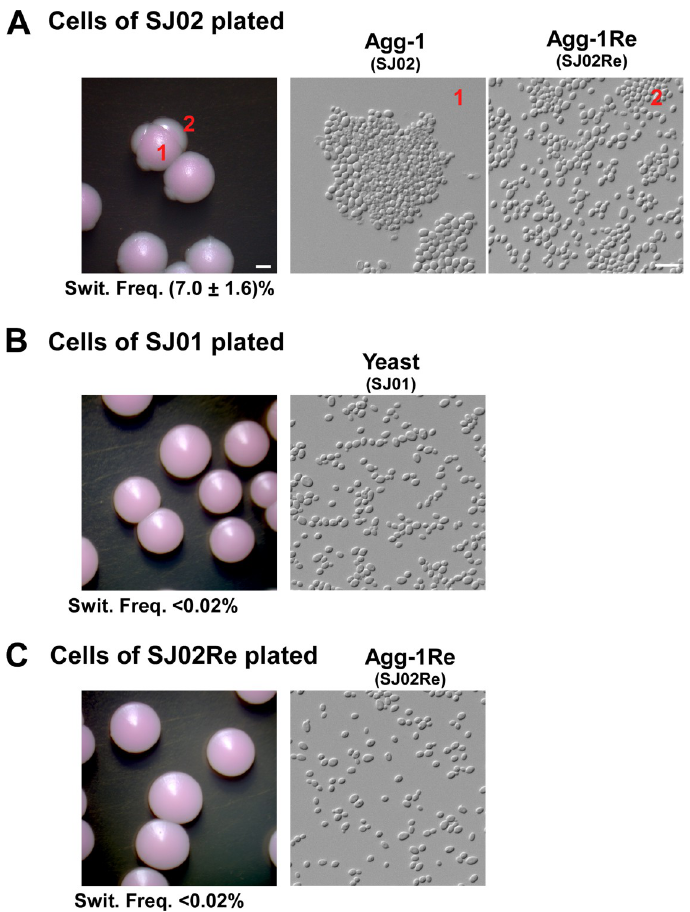
Fig 3. Spontaneous switching between the aggregating form and the single-celled nonaggregative/yeast-form. C . auris cells of the original aggregating form (Agg-1, SJ02), SJ01 nonaggregative/yeast-form, or SJ02Re nonaggregative/ yeast-form were plated onto solid YPD medium containing 5 μ g/mL phloxine B and cultured at 30˚C for 5 days. (A) Colony and cellular morphologies of the aggregating form (Agg-1, SJ02) and spontaneously generated nonaggregative/ yeast-form (sectors, Agg-1Re or SJ02Re). (B and C) Colony and cellular morphologies of the nonaggregative/yeast- form strains (SJ01) and (SJ02Re). Switch frequencies to the alternative form were shown below the corresponding colony images. < 0.02% indicates no alternative morphological cells observed. Scale bar for cells, 10 μ m; scale bar for colonies, 1